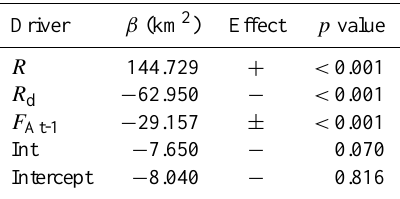
Figure 2. The upper Fortescue River catchment 1912–2012 hy- droclimate with (a) frequency distribution of total yearly rainfall and (b) average monthly rainfall for months recording at least one tropical cyclone (TC) within 500km radius of the upper Fortes- cue River catchment (blue line) and without TC recorded (black line), with the number of years (frequency) where TC occurrence was recorded for each month of the water year (blue columns); only one occurrence of TC was recorded in November and May for the last century and thus rainfall averages for these months are not included. Source: http://www.bom.gov.au/cgi-bin/silo/cli_var/ areatimeseriespl and